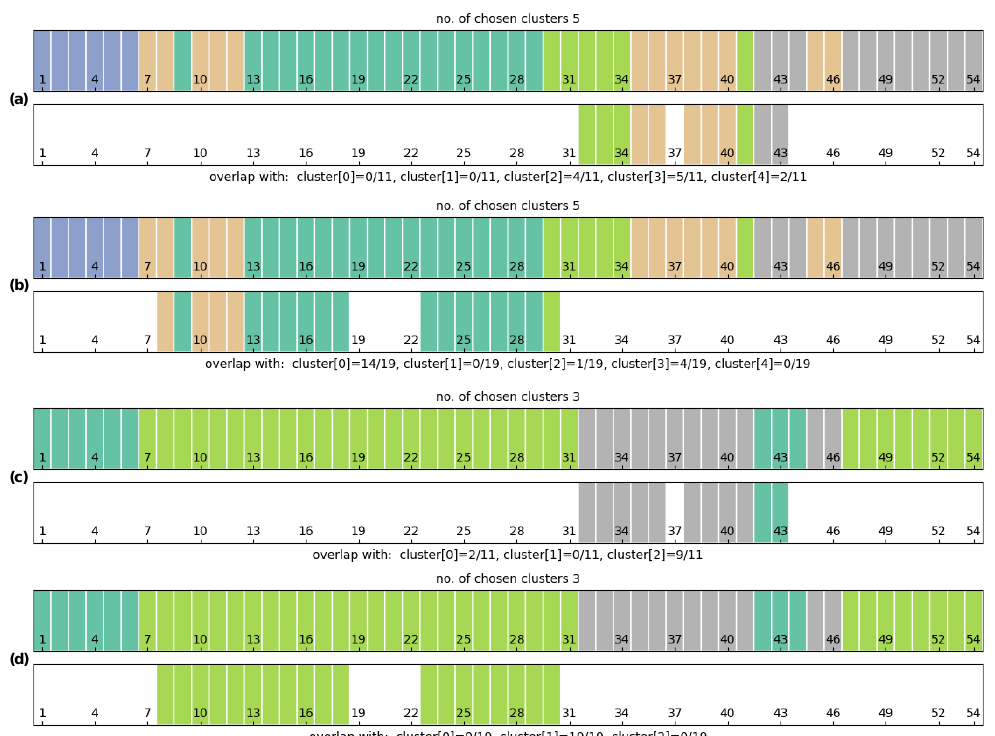
Figure 4. Comparison of clustering results with a given number of the desired clusters (top rows) obtained with the Subspace Memory Clustering (SuMC) algorithms with respect to ground truth (bottom rows). ( a , b ) contain the results for selected 5 clusters; ( c , d ) contain the results for selected 3 clusters. The clusters are color-coded (top rows) and put against the patterns recognized by the domain-experts. Each bar constitutes a single point in the DS1 dataset and each cluster is represented by a different